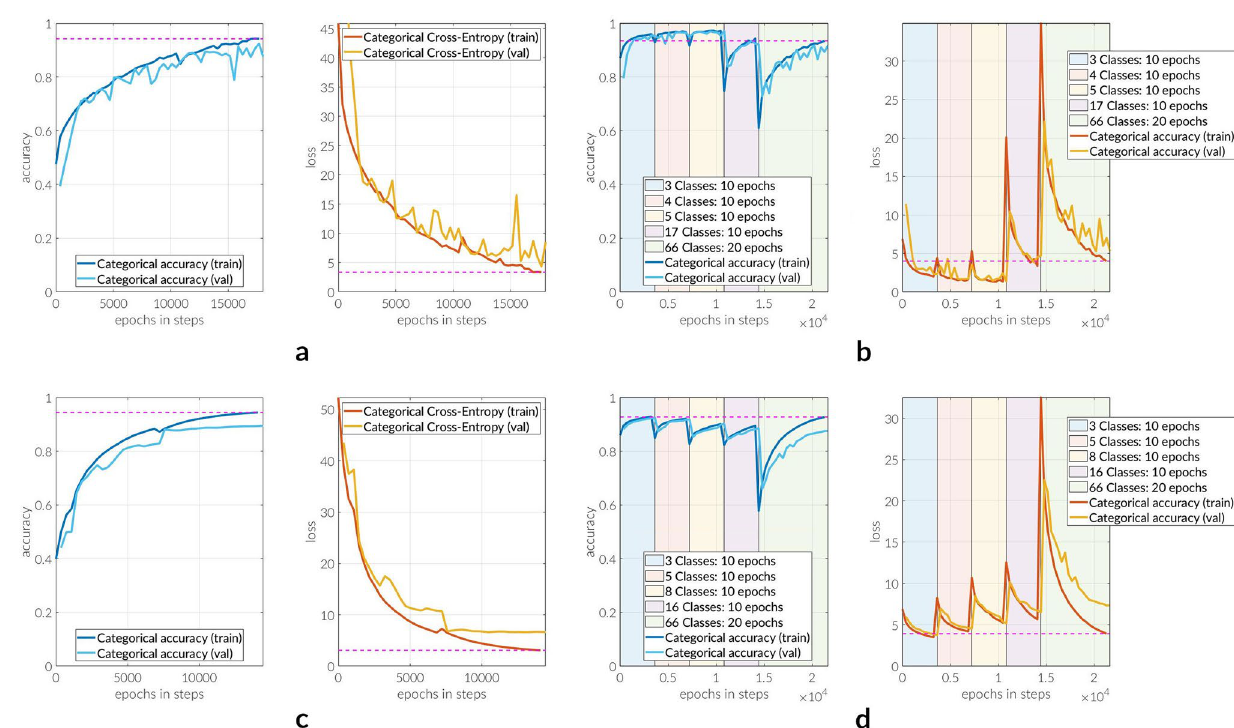
Figure 4. Training histories. Training histories of U-Net and DeepLab Model. ( a , c ) Show the conventional approaches during which the networks learn to distinguish between all 66 classes (including background) from the very beginning. Before the start of the training, all weights are initialized to 0. In all cases, one epoch consists of 361 steps each. ( b , d ) on the other hand visualize the training progress of the proposed STL method. All training rounds except for the first one rely on weights which have been computed based on the preceding training setup. All charts contain training and validation performances in terms of categorical accuracy and categorical cross-entropy (loss), respectively. ( a ) U-Net model Training history of a conventionally trained network model. Training is performed for 50 epochs. ( b ) U-Net model Training history of a network model trained using the proposed STL approach. In total, training is conducted for 60 epochs. ( c ) DeepLab model Training history of a conventionally trained network model. Training is performed for 40 epochs. ( d ) DeepLab model Training history of a network model trained using the proposed STL approach. In total, training is conducted for 60